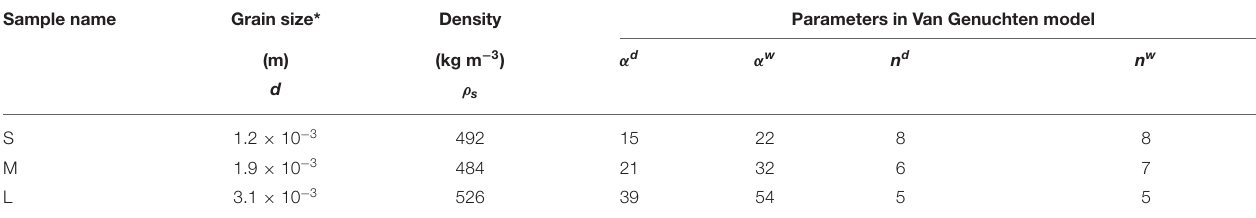
TABLE 1 | Information of snow samples for investigation of hysteresis of snow water retention curve.